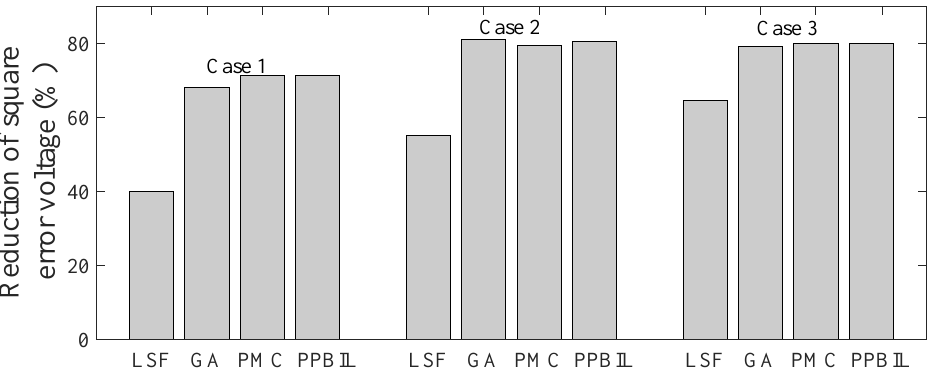
Figure 11. Reduction of square error voltage in test system with the 33 buses.